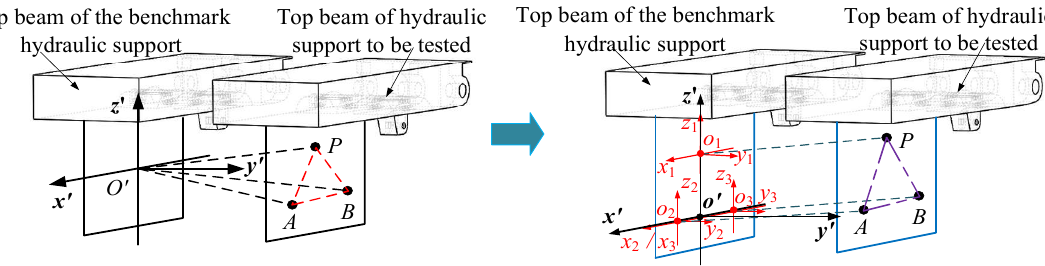
Figure 3. Schematic diagram of detecting the relative position and posture of the top beam of hydraulic support.